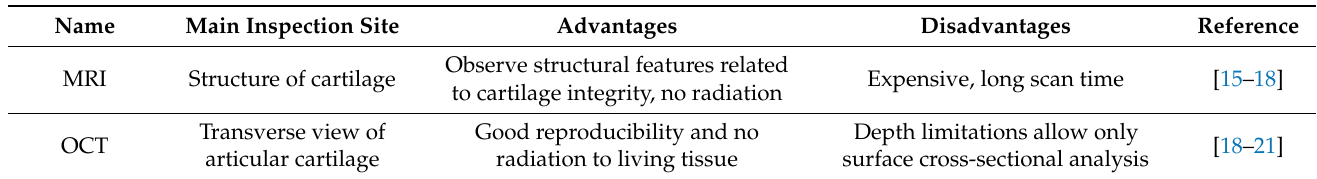
Table 1. Comparison table of application analysis of traditional imaging methods in relation to osteoarthritis (OA).